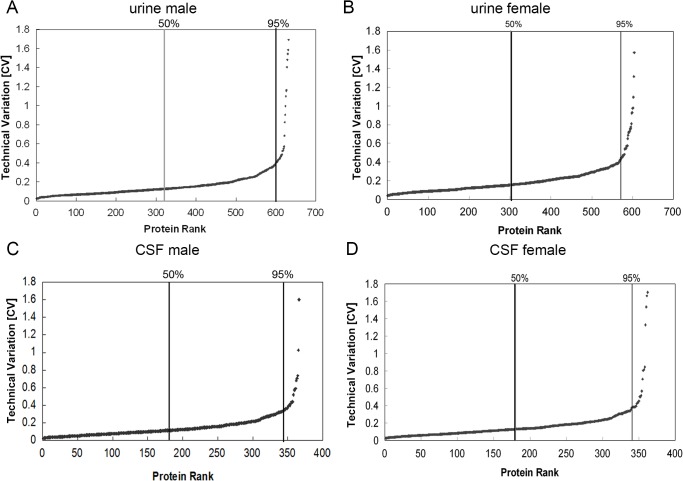
Technical variation in urinary and CSF proteomes.The technical variations in male (A) and female (B) urinary proteomes are shown. The technical variations in male (C) and female (D) CSF proteomes are shown. The proteins with median and top 5% technical CVs are annotated in the figures.